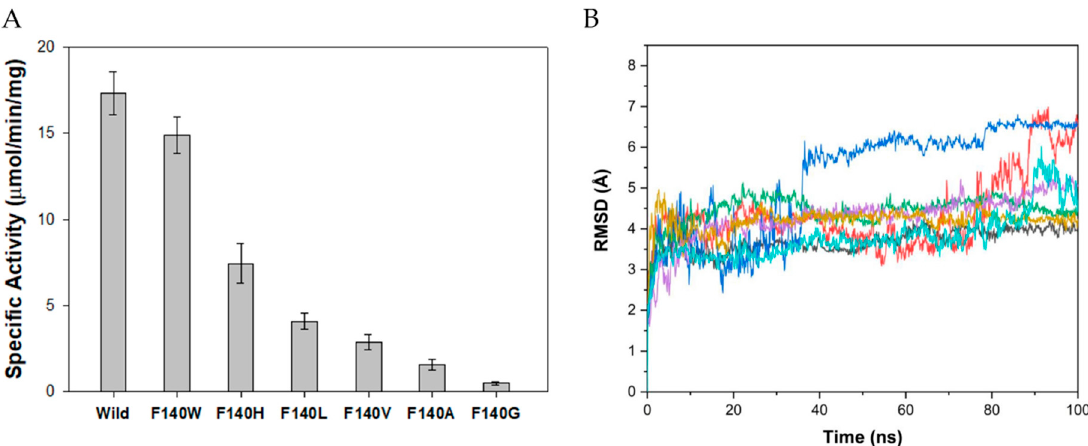
Figure 5. Activity and stability analysis of NitAF variants. ( A ) Catalytic activities of NitAF wild-type and mutants produced by site-directed mutagenesis at position 140. Specific activities with phenylacetonitrile (15 mM) were determined. Each value represents the mean of triplicate measurements with standard deviation less than 15%. ( B ) MD simulation on NitAF variant structures. Wild-type (black), F140G (blue), F140A (red), F140V (light blue), F140L (purple), F140H (green), and F140W (yellow) are shown.